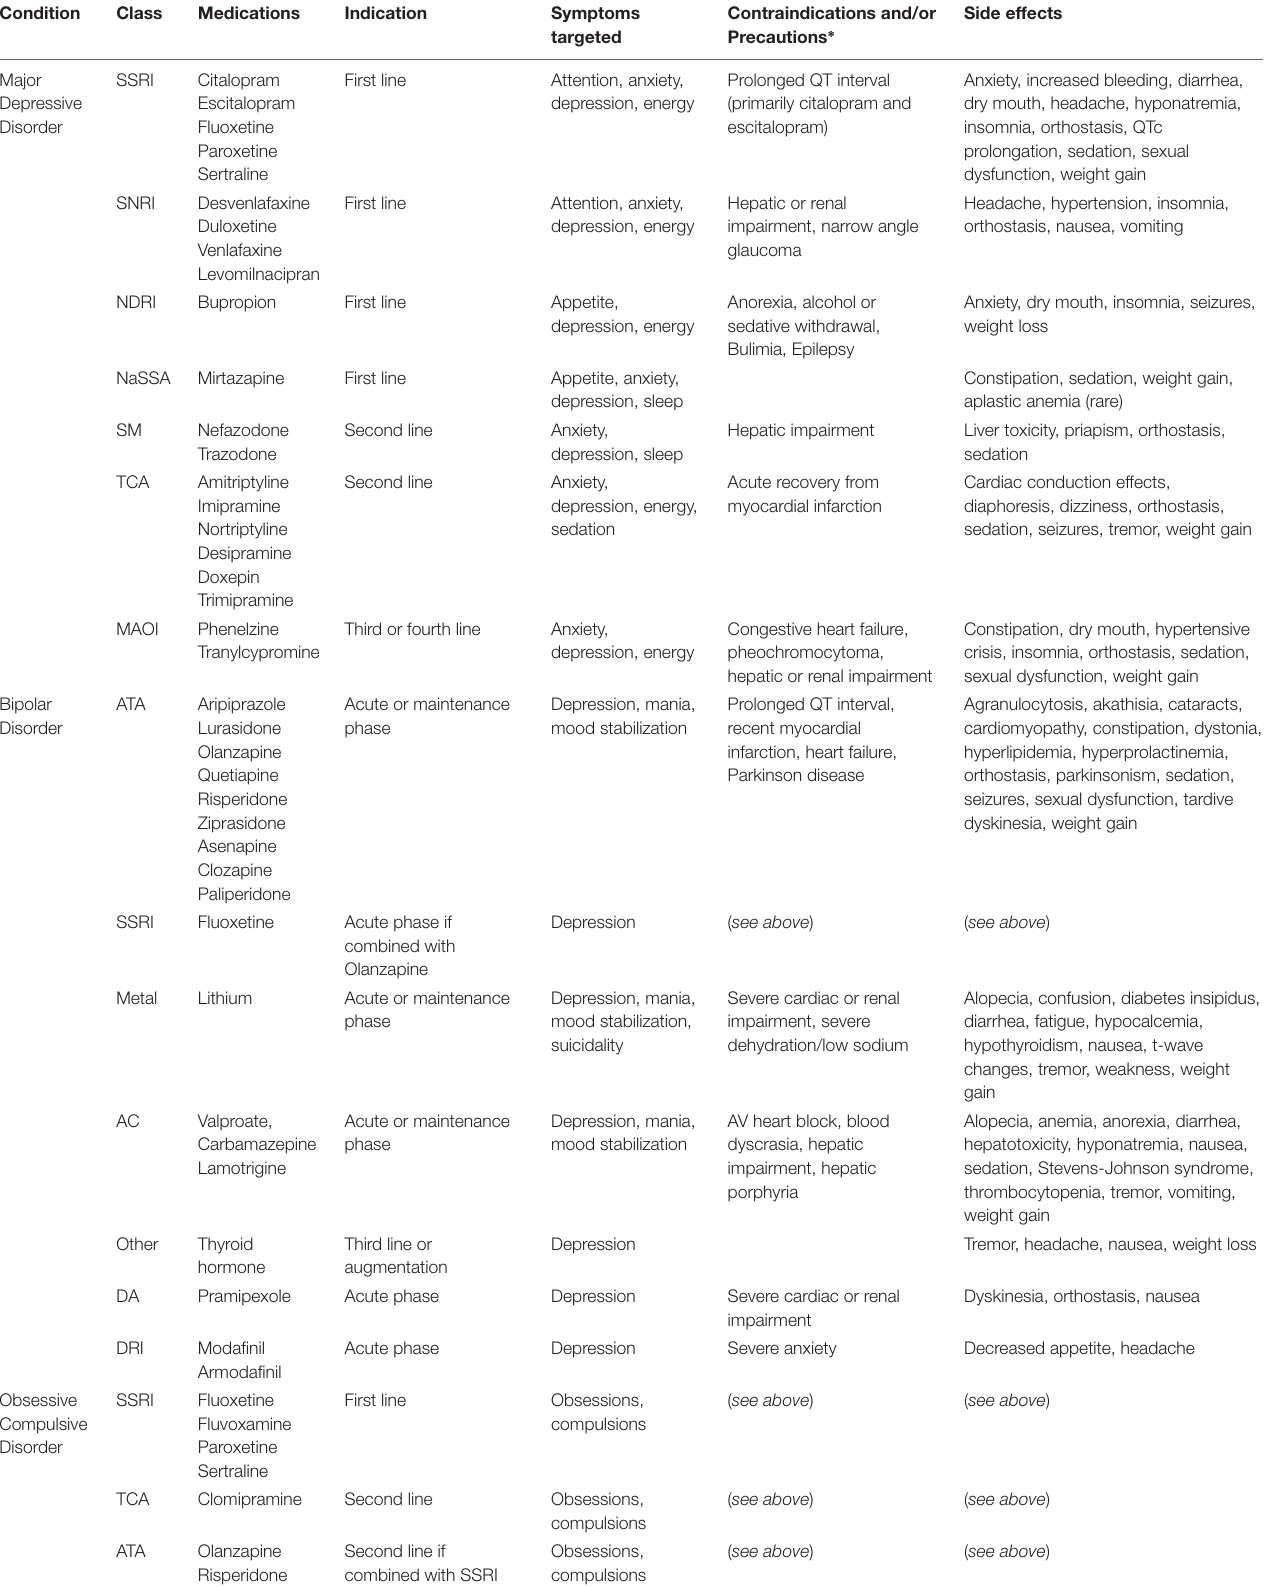
TABLE 1 | Summary of modern psychopharmacological agents.